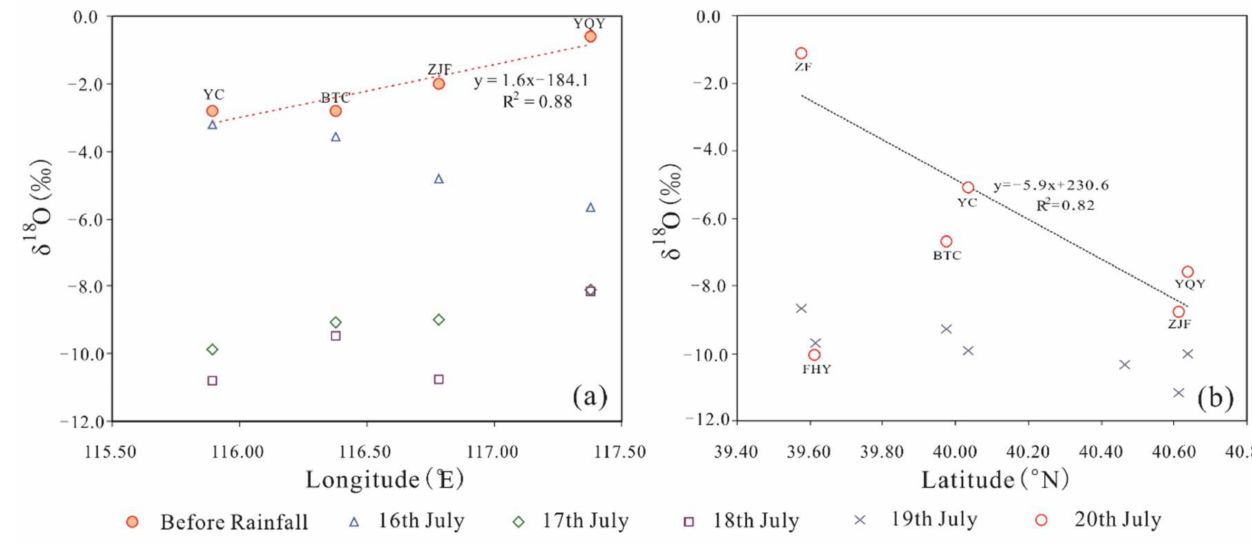
Figure 9. The plot of δ 18 O versus ( a ) longitude and ( b ) latitude for continuous precipitation events at seven